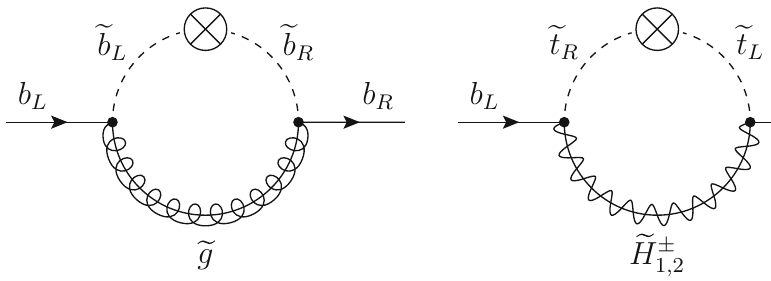
Fig. 10 Diagrams contributing (α s ,α t ) to (cid:2) O